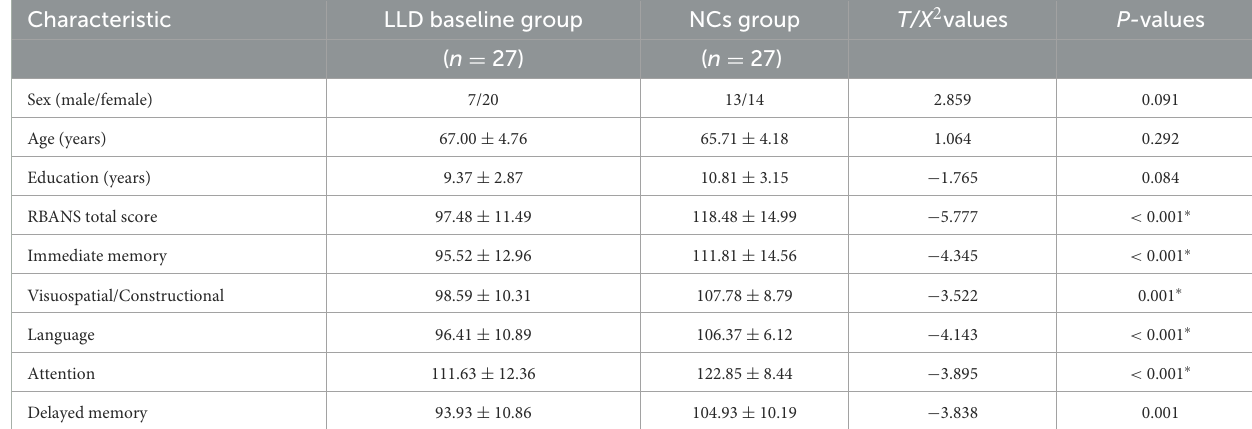
TABLE 1 Demographics and neuropsychologic data between the LLD baseline group and NCs group.